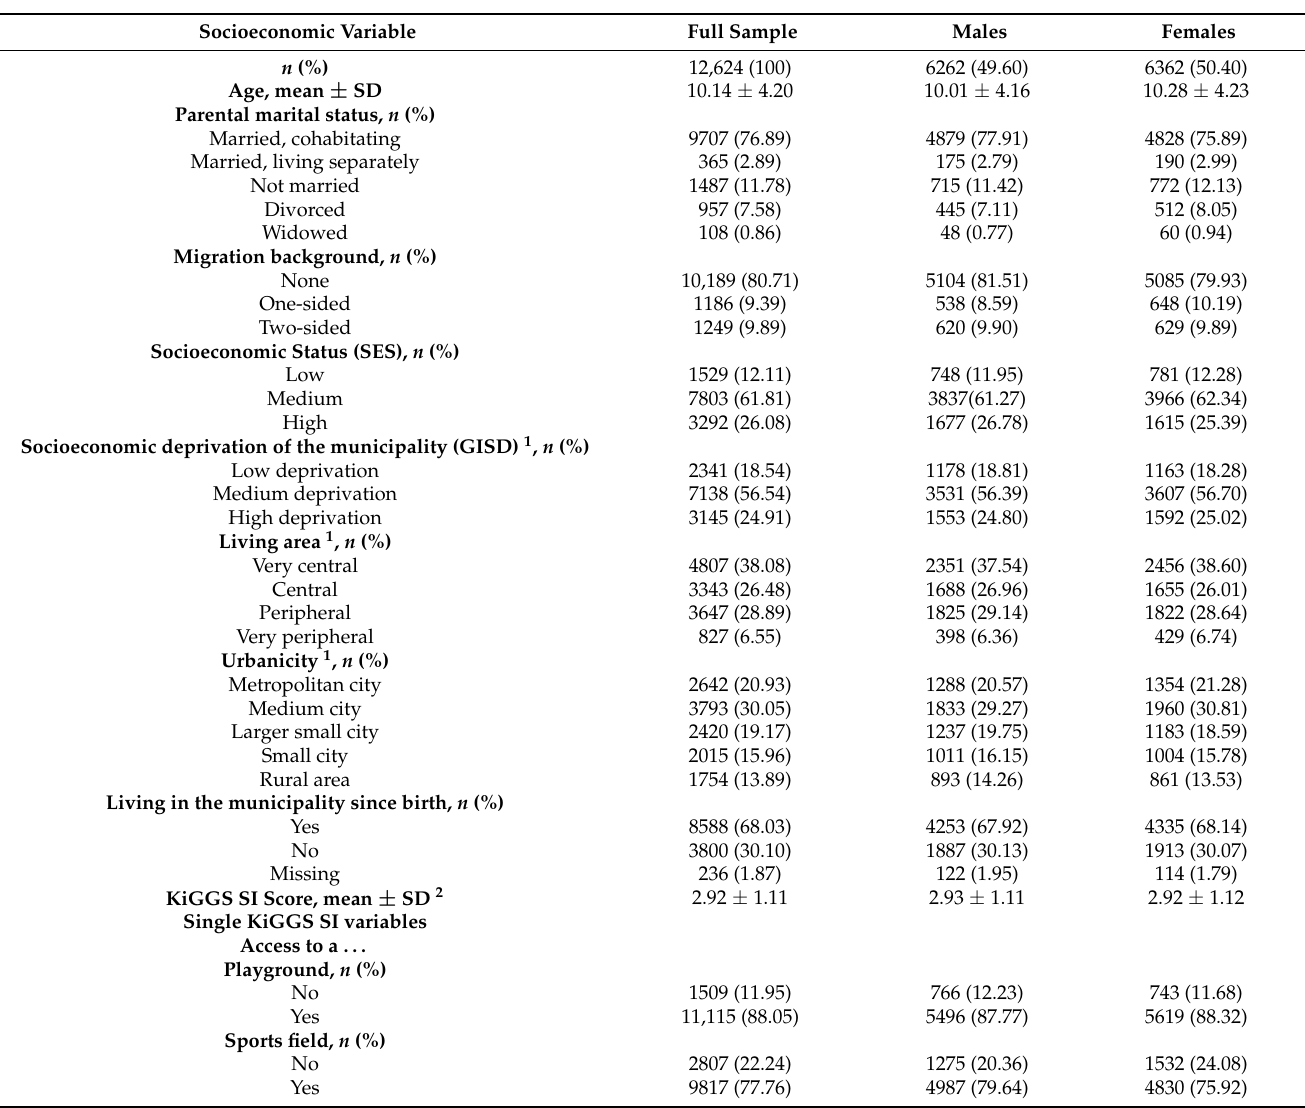
Table 1. Sex-stratified characteristics of socio-demographic, social infrastructure, and mental health